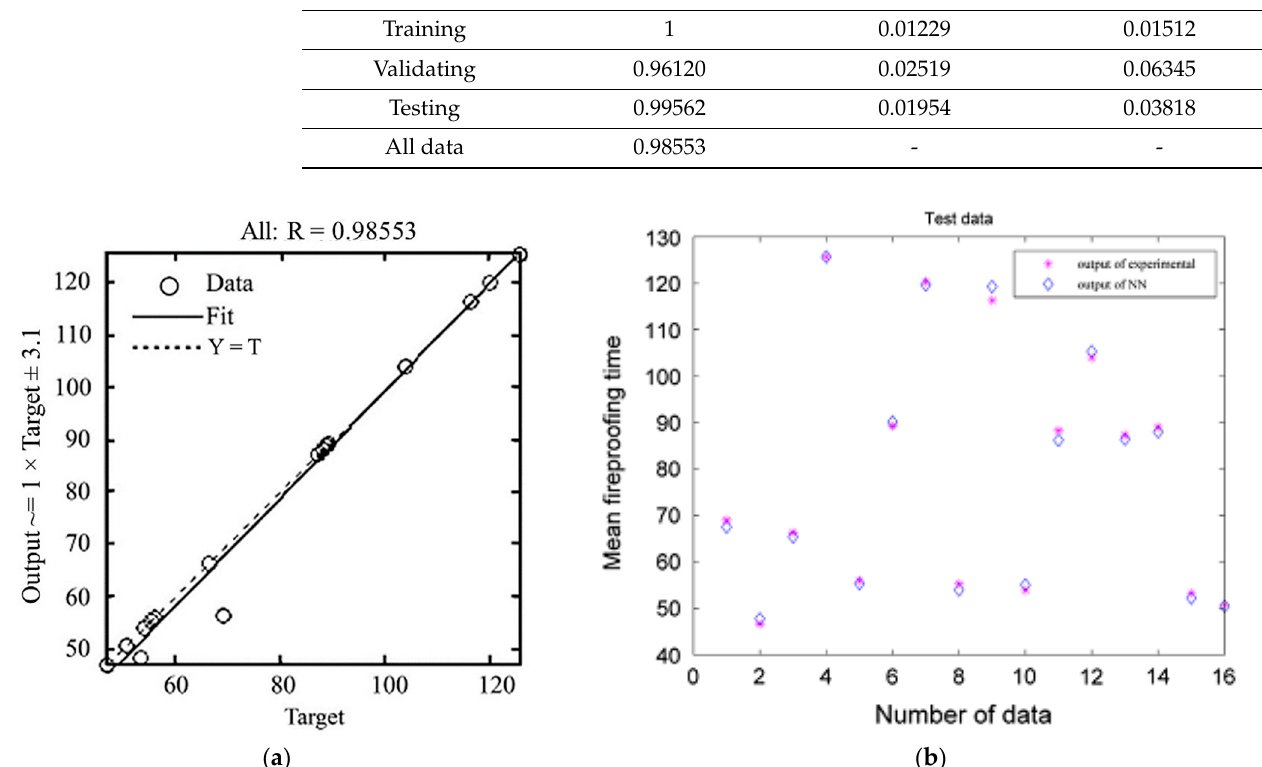
Figure 7. ( a ) The regression plot of the ANN-predicted result against the experimental data. ( b ) A comparison between the predicted outcomes of the ANN model and the practical results in terms of the mean fireproofing time (MFPT). Adapted with permission from ref. [99]. Copyright 2013 Fire Safety Journal.